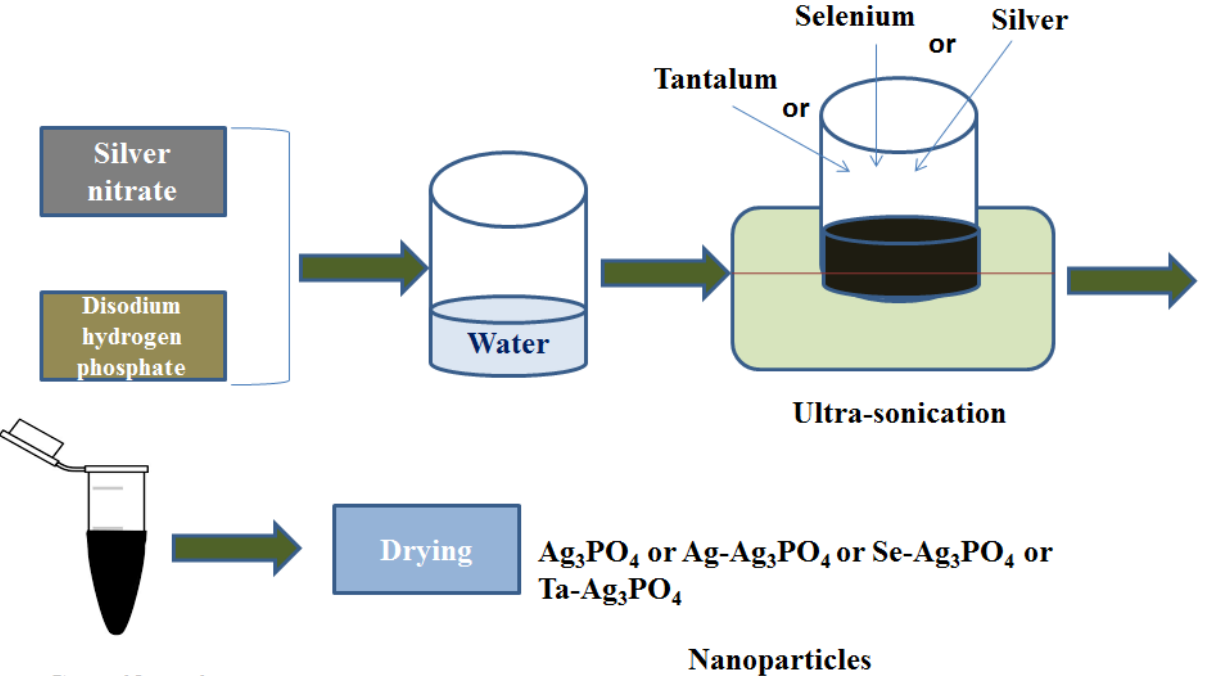
Figure 13. Schematic representation of Ag 3 PO 4 , Se-Ag 3 PO 4 , Ag-Ag 3 PO 4 , and Ta-Ag 3 PO 4 nanoparti-